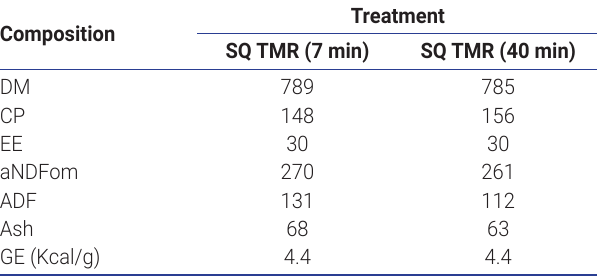
Table 4. Chemical composition of Sasa quelpaertensis Nakai TMR feed at different mixing times (g/kg dry matter, unless